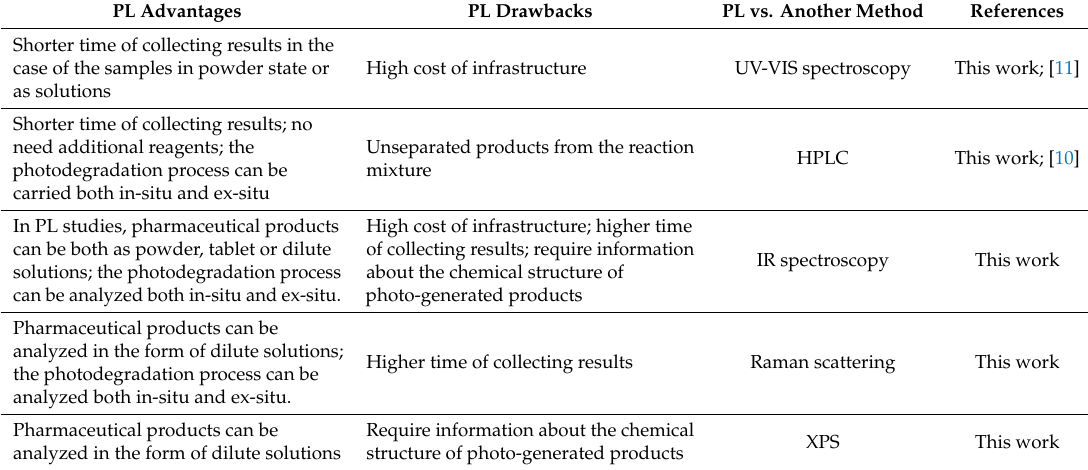
Table 2. The most important advantages and drawbacks of the PL in comparison with other methods to assess the photodegradation processes of the pharmaceutical compounds. PL Advantages PL Drawbacks PL vs. Another